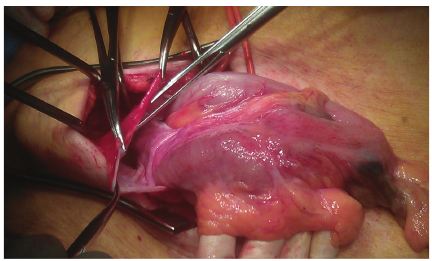
Figure 3: Opening of the inguinal hernia sac revealing the sigmoid colon with spotted tumour.